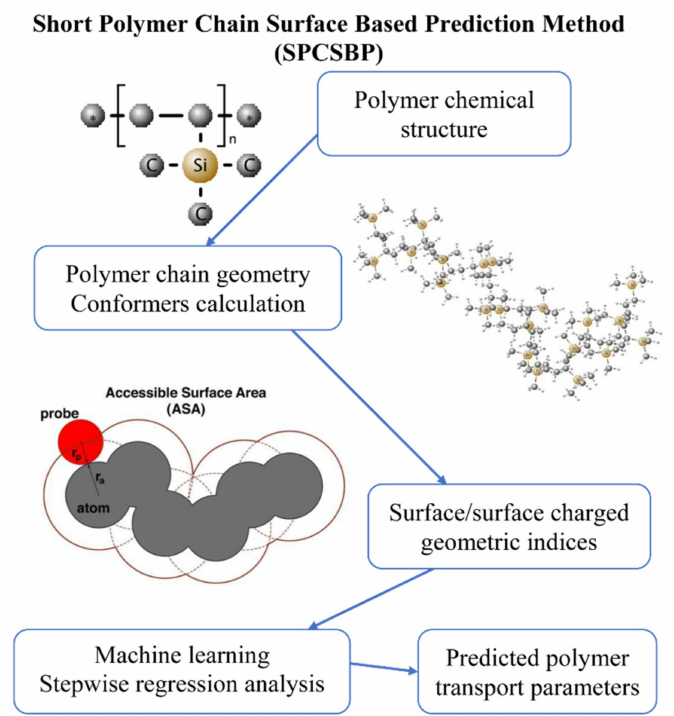
Figure 4. SPCSBP method